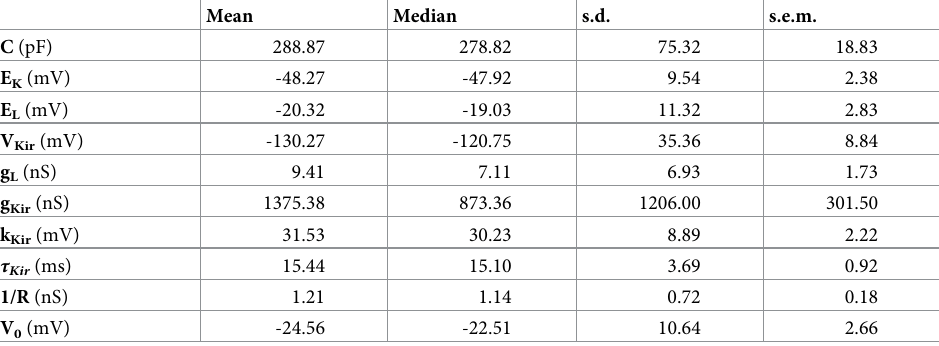
Table 1. Statistics of fitted parameters (n = 28) for hyperpolarized responses (model with two